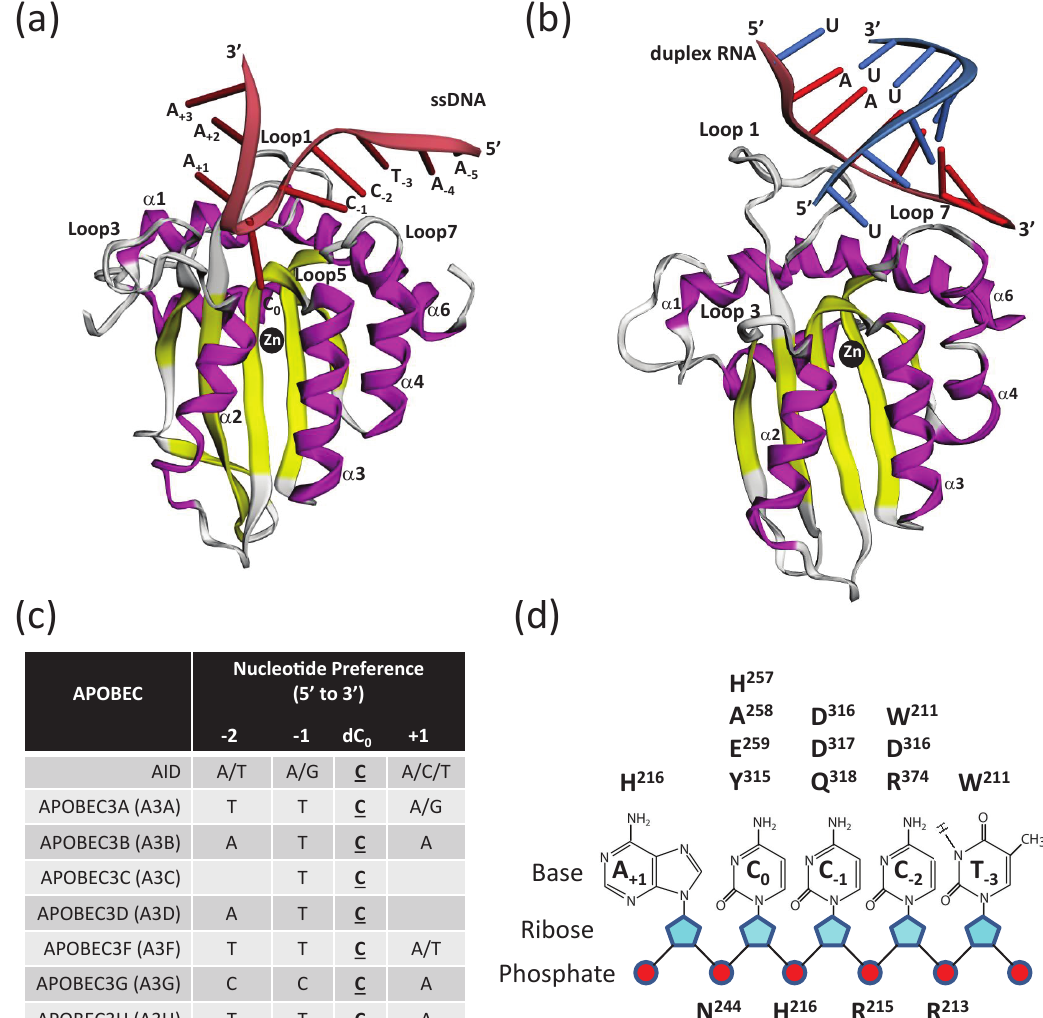
Figure 6. A3 deamination and ssDNA interactions. ( a ) Co-crystal structure of A3G CTD in complex with ssDNA substrate 5 (cid:48) -AATCCCAAA-3 (cid:48) (PDB 6BUX). Shown is the three-dimensional fold of the A3G CTD with α -helices (purple) and β -sheets (yellow) with the ssDNA (red) co-ordinated with the reactive cytosine (C 0 ) positioned next to the catalytic zinc atom. Loops 1, 3, 5, and 7, which influence substrate binding, specificity, and dinucleotide preference selection, are labeled. ( b ) Co-crystal of A3H in complex with duplex RNA substrate 5 (cid:48) -UAAAAAAA-3 (cid:48) + 5 (cid:48) -UUUUUUUUU-3 (cid:48) with a 1 nucleotide overhang (PDB 6B0B). Shown are α -helices (purple) and β -sheets (yellow) with the duplex RNA (red and blue) positioned with zinc atom. ( c ) Preferred ssDNA substrates of the A3 enzymes where the underlined C is the preferred target nucleotide of the deamination reaction. ( d ) Summary of the interactions of the 5 (cid:48) -TCCCA target ssDNA substrate with amino acids in A3G CTD (PBD 6BUX). A3G loop 1 contains amino acids W211, R213, R215, H216; A3G loop 3 contains amino acids N244, H257; A3G α -helix 2 contains amino acids A258 and E259; A3G loop 7 contains amino acids Y315, D316, D317, Q318 and A3G α -helix 6 contains amino acid